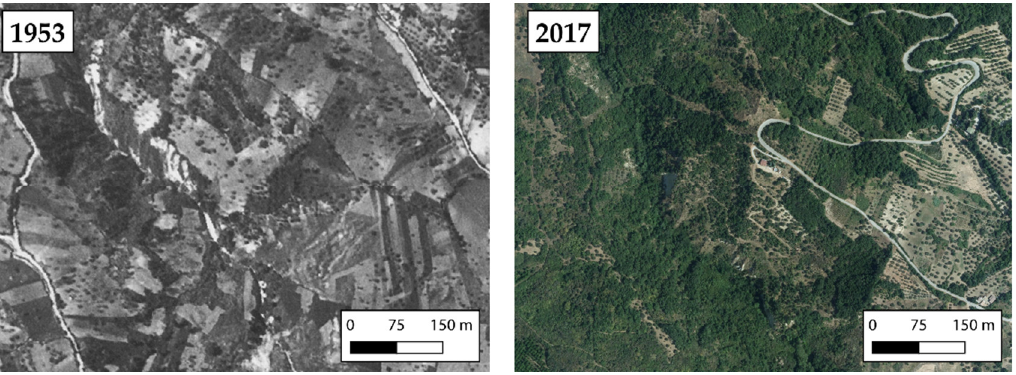
Figure 3. The same portion of the study area in 1953 aerial photos and 2017 orthophotos.